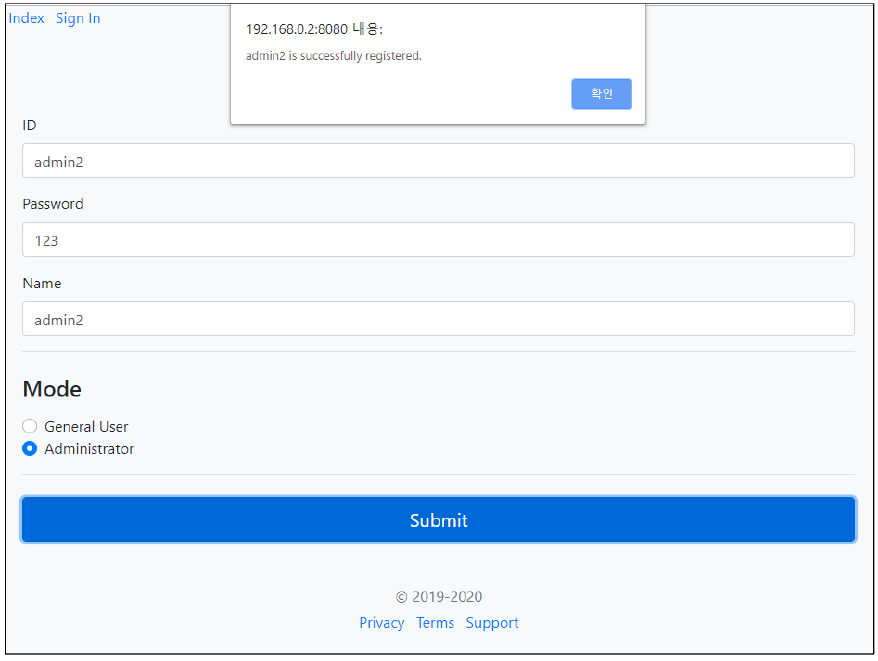
Figure 11. Result of creating a user using the createUser API.